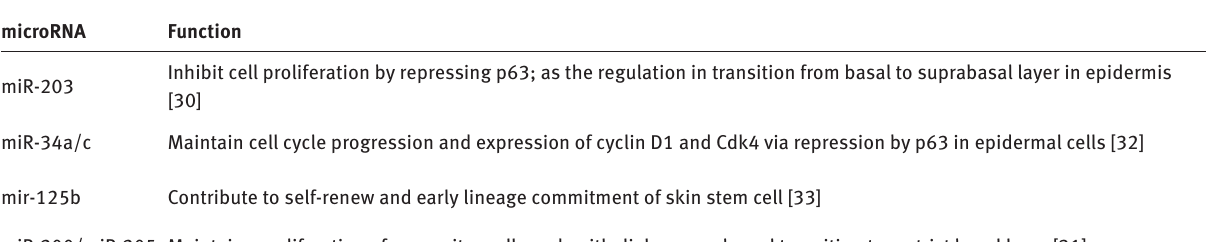
Table 1: microRNAs involved in skin development